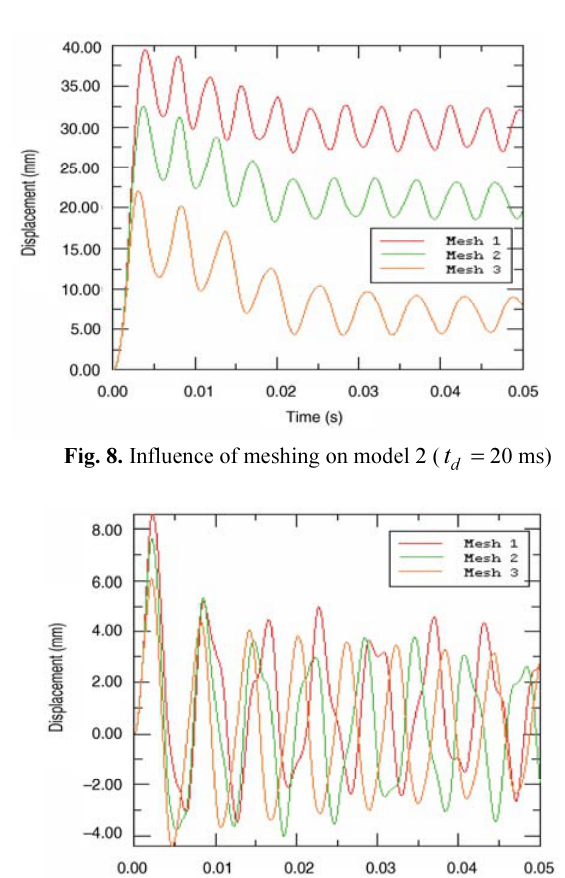
Fig. 7. Influence of meshing for model 1 ( d